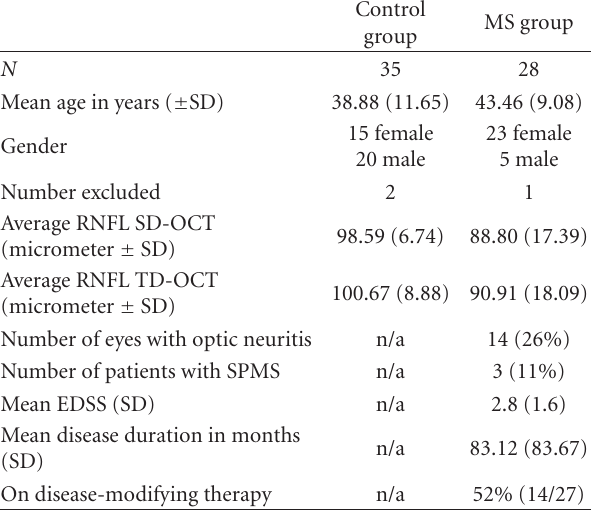
Table 1: Descriptive statistics of MS and control